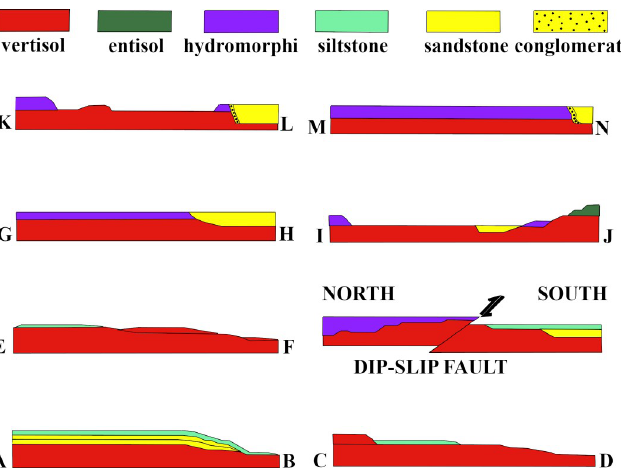
Fig 11. Sedimentary profiles of the cross-sections A-B to M-N. The sedimentary profiles of the cross-sections A-B to M-N were drawn based on the field observations and drill cores. The profiles are not scaled and are meant to complement the map in Fig 2. The variations in sediment sizes, the thickness of the deposits, and planar exposures are shown from sections A-B to M-N.